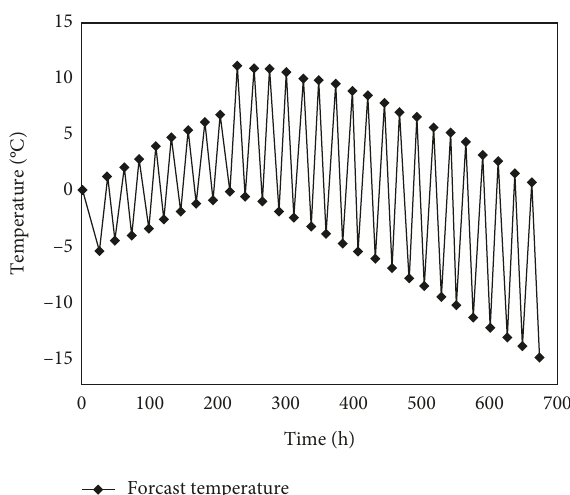
Figure 8: SVM predicts the temperature amplitude at which freeze-thaw cycles may